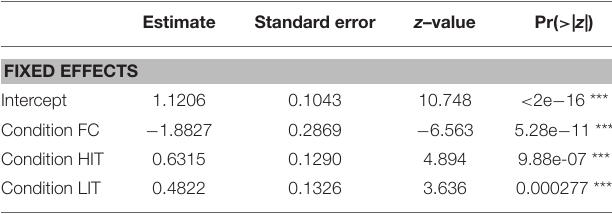
TABLE 3 | GLM results showing the effect of experimental conditions on gazing behavior in the